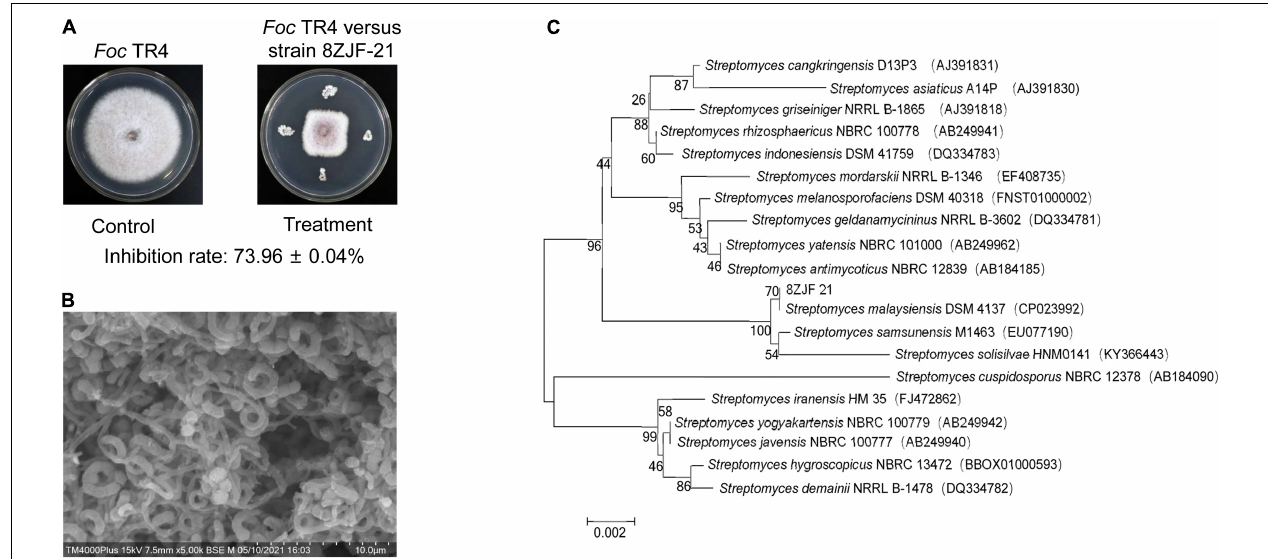
FIGURE 1 | Antifungal activity and identification of strain 8ZJF-21. (A) Antifungal activity of strain 8ZJF-21 on mycelial growth of Foc TR4. (B) Morphology of strain 8ZJF-21. (C) Phylogenetic tree of strain 8ZJF-21 using 16 rDNA sequences. The tree was constructed using the NJ method in the MEGA software. The level of bootstrap support (1,000 repetitions) was indicated at all nodes.